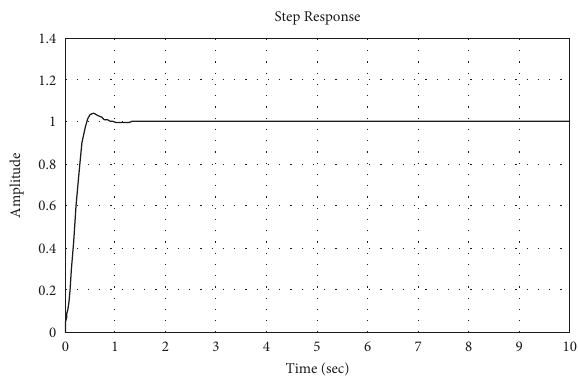
Figure 8: Step response curve of the system after pole configuration.